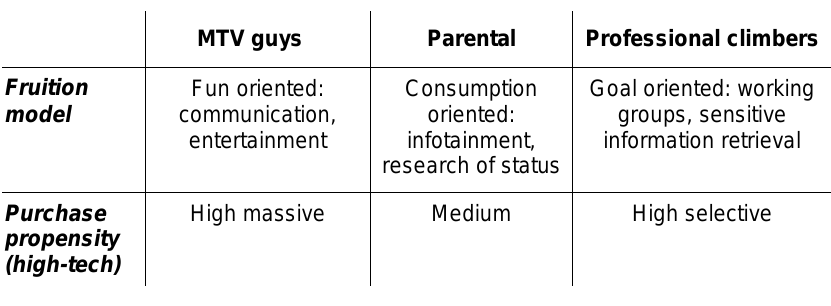
Table 1: Lifestyles, Fruition Model and Purchase